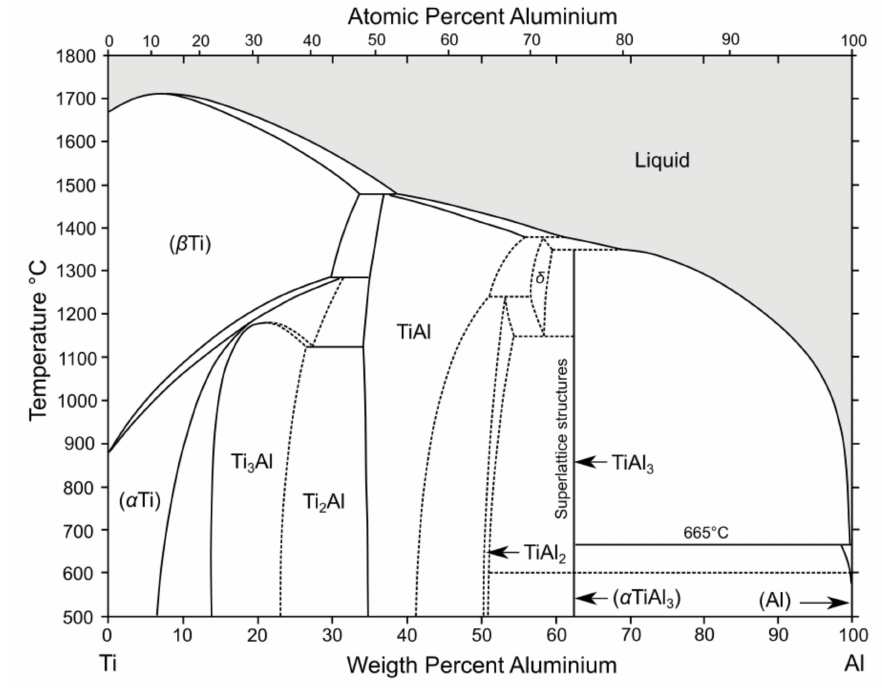
Figure 24. Binary Al-Ti phase diagram. Redrawn from [88] with permission.